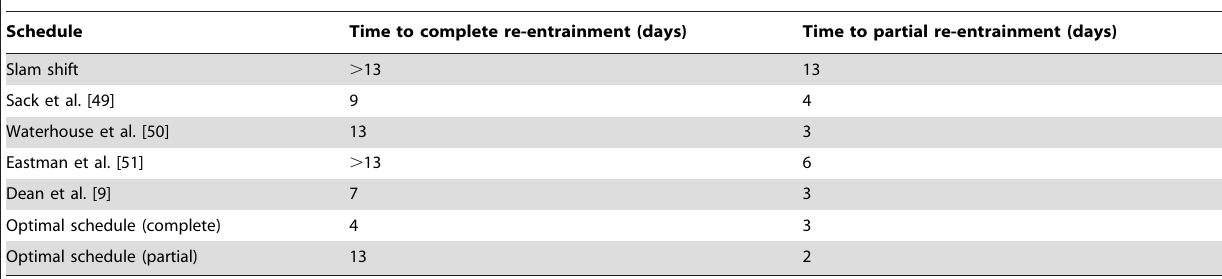
Table 1. Times to re-entrainment under the schedules presented in figure